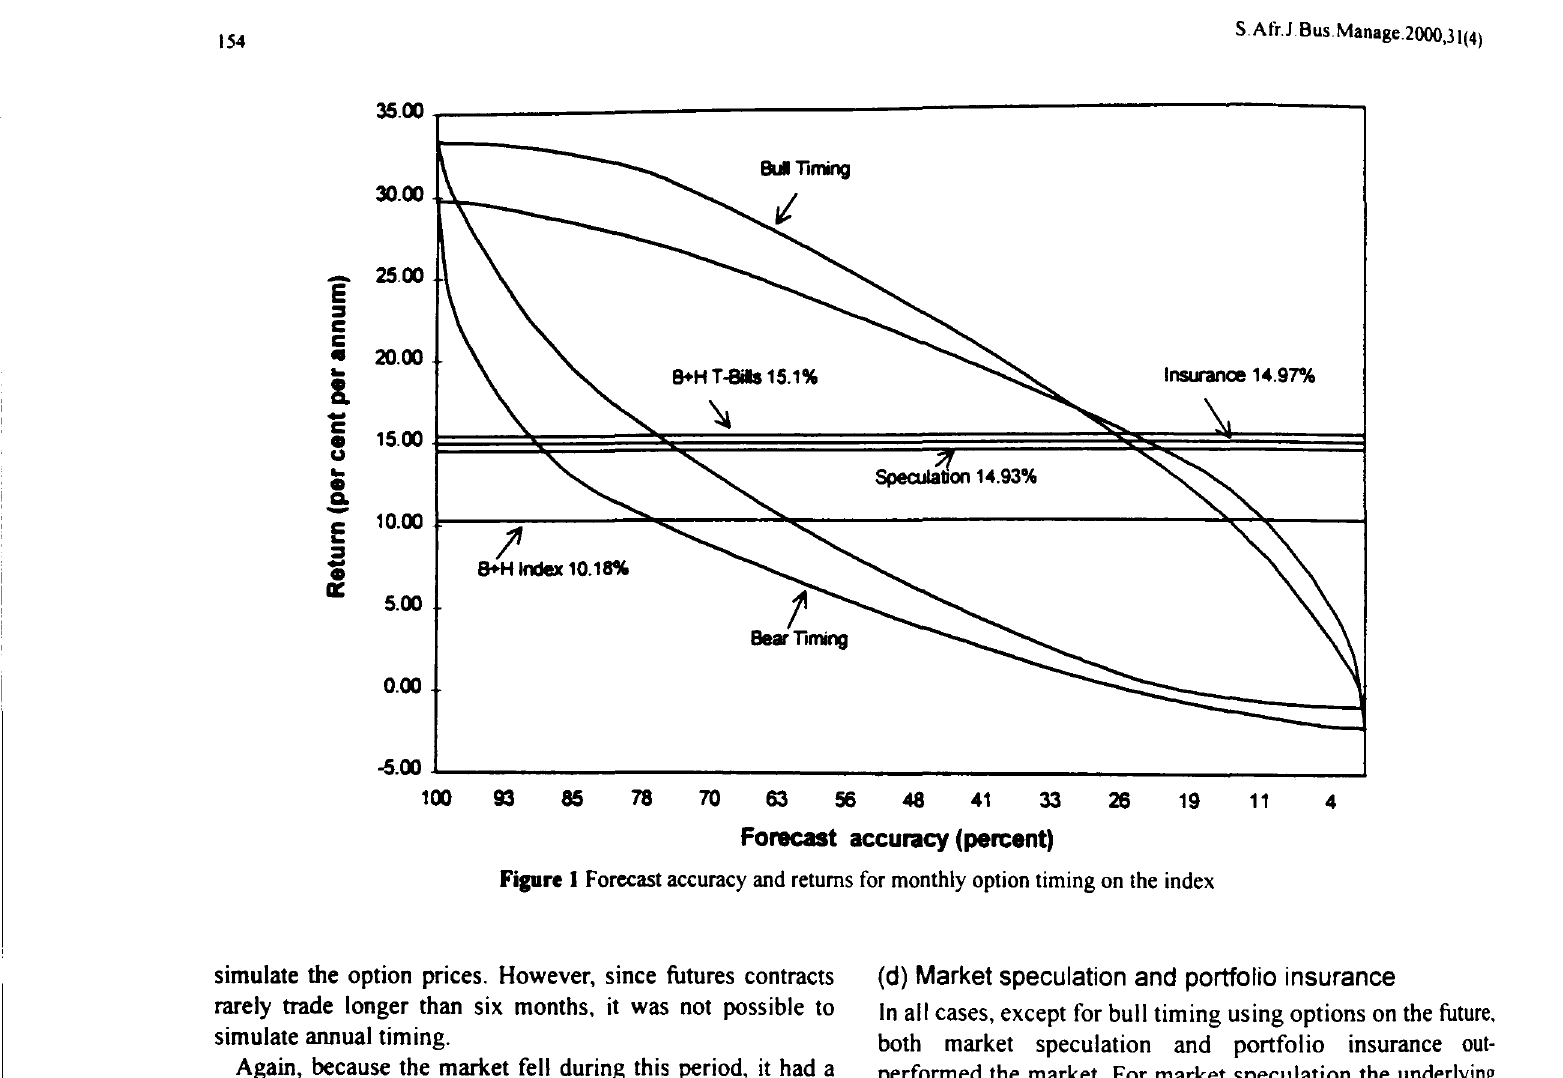
Figure I Forecast accuracy and returns for monthly option timing on the